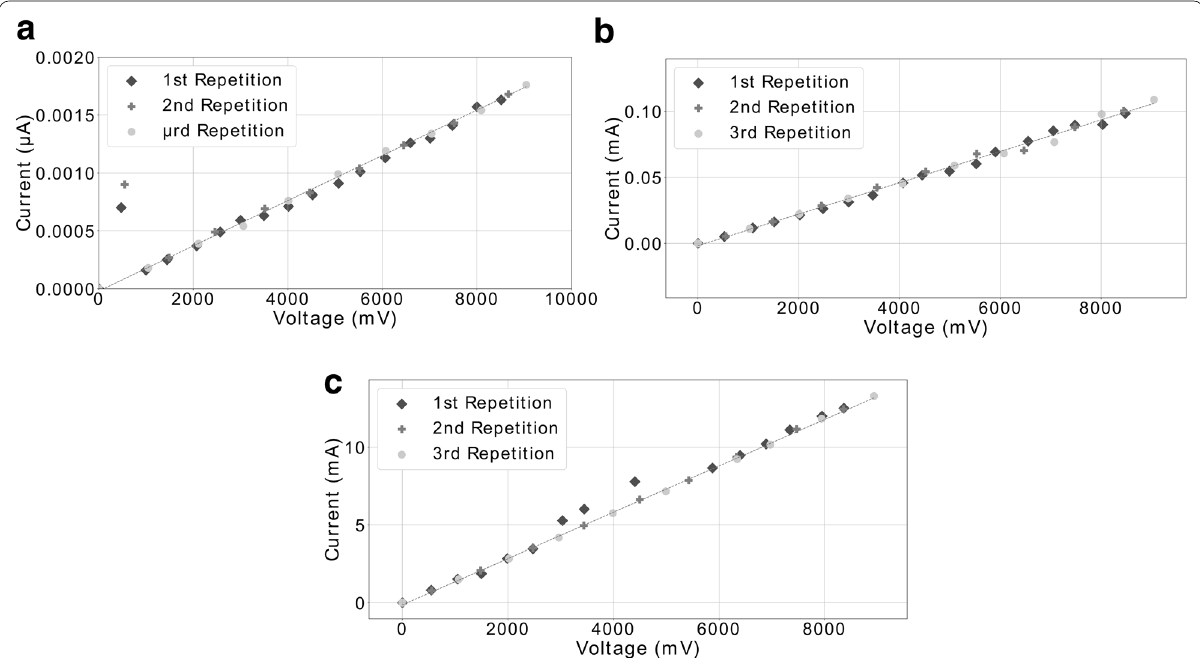
Fig. 8 Curves I–V using DC for samples with ( a ) 0.2 % wt of CNTs, b 0.5 % wt , and c 0.8 % wt